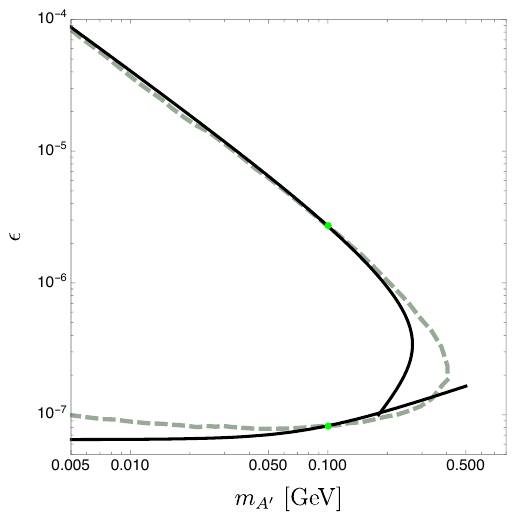
Figure 9 . Our fitting with the results of ref. [4] for E137. Dashed light green line shows the boundary of the existing constraint by E137 which is taken from ref. [4], while the black solid lines show our fit. Green points on the boundaries are our reference points for the